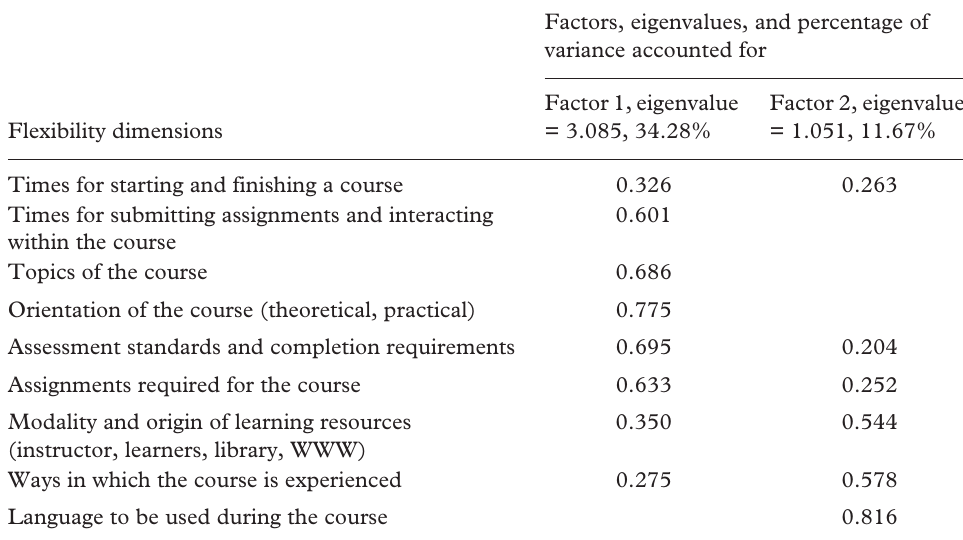
Table 3. Rotated factor solution, flexibility dimensions as practiced by instructors ( n =